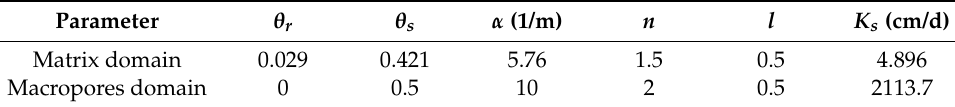
Table 2. Slope calculation